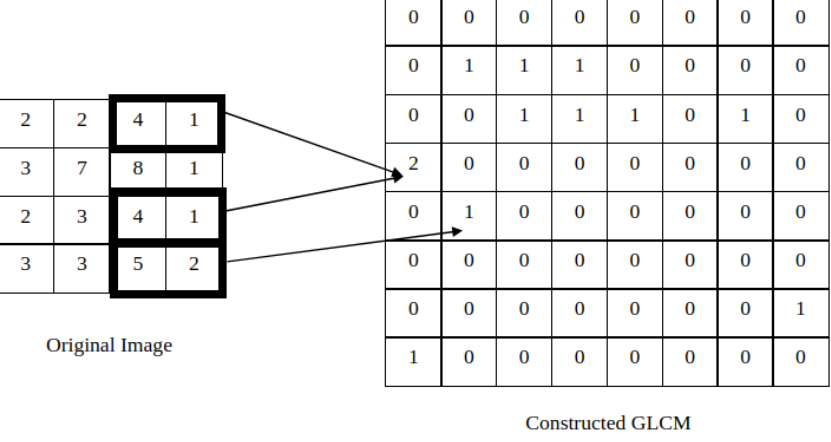
Figure 1. Construction of the GLCM for the 0 ◦